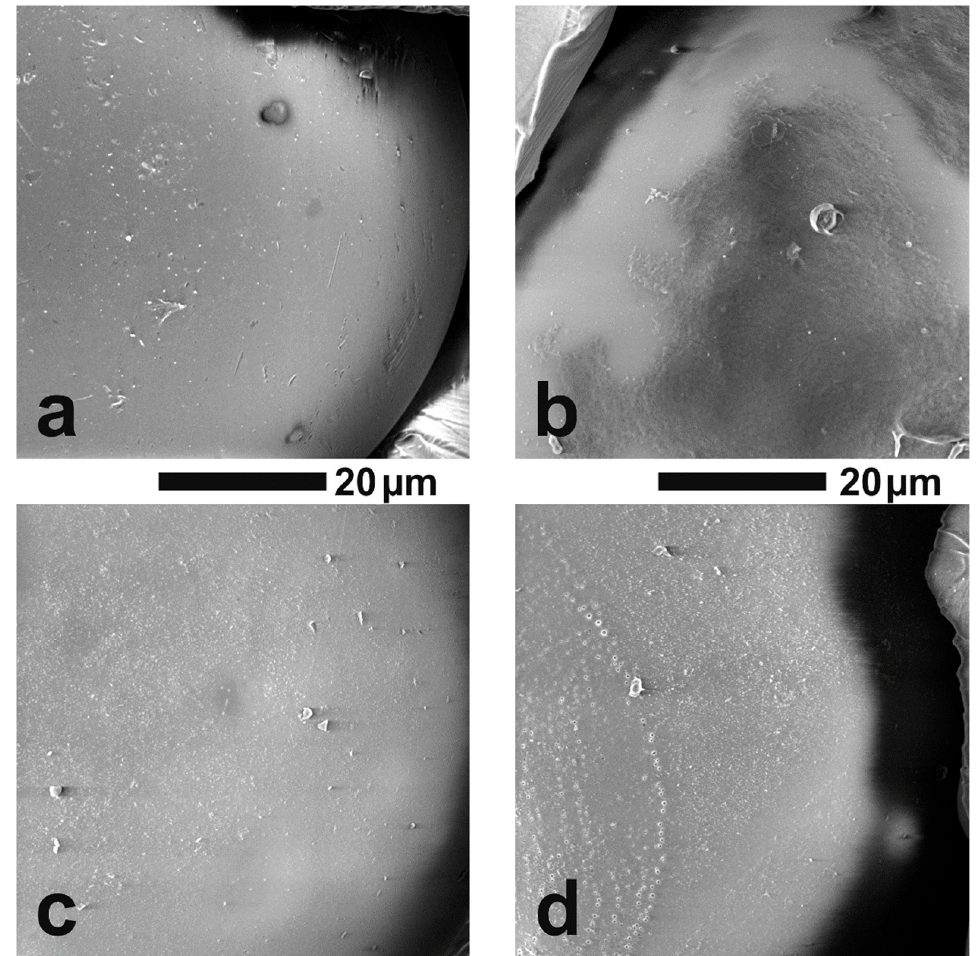
Figure 3. The grain surface of the tested resins at a magnification of 5000×: ( a ) VBC-D3EI, ( b ) VBC-D4EI, ( c ) VBBr-D3EI, ( d ) VBBr-D4EI.